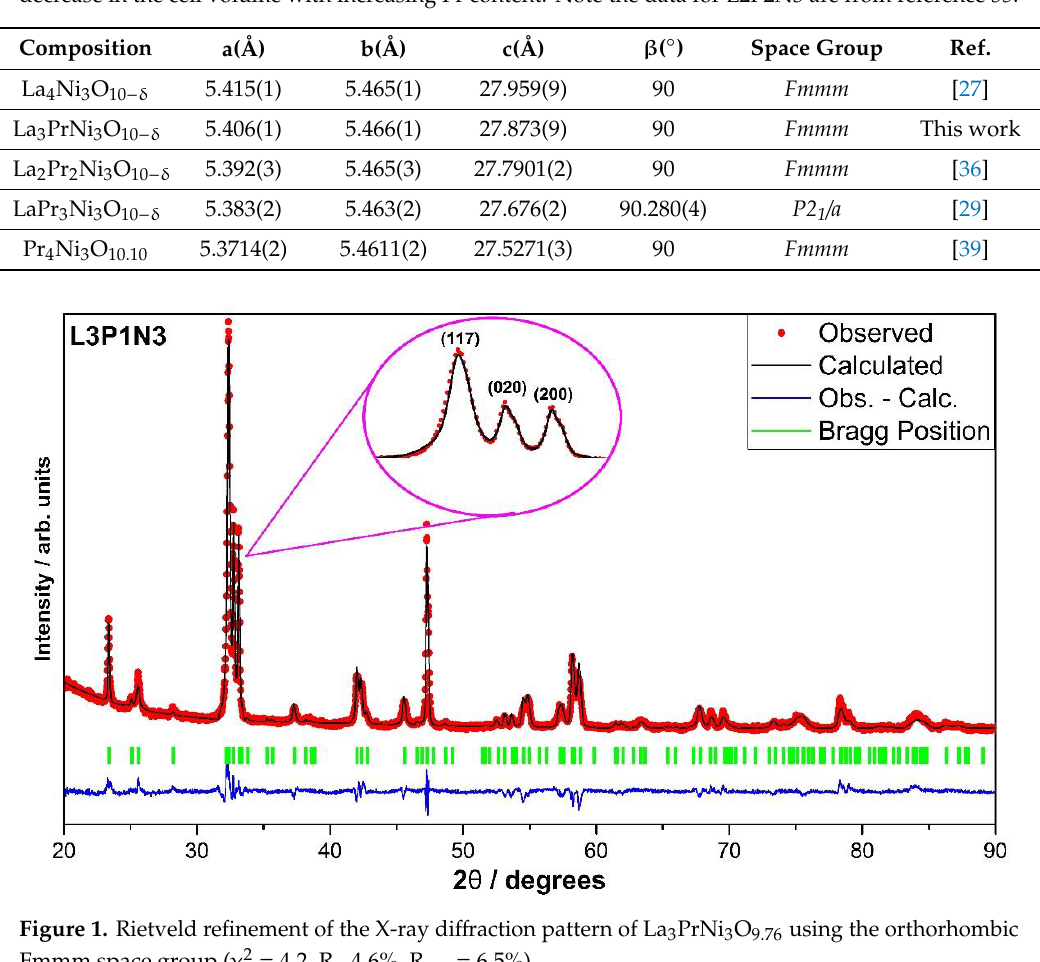
Table 2. Unit-cell parameter comparison of the prepared compositions of L2P2N3 and L3P1N3. The two end members, L4N3 and P4N3, are also included to show the systematic decrease of lattice parameters with increasing Pr content, which is consistent with the variation of the ionic radii, leading to an overall decrease in the cell volume with increasing Pr content. Note the data for L2P2N3 are from reference 35.